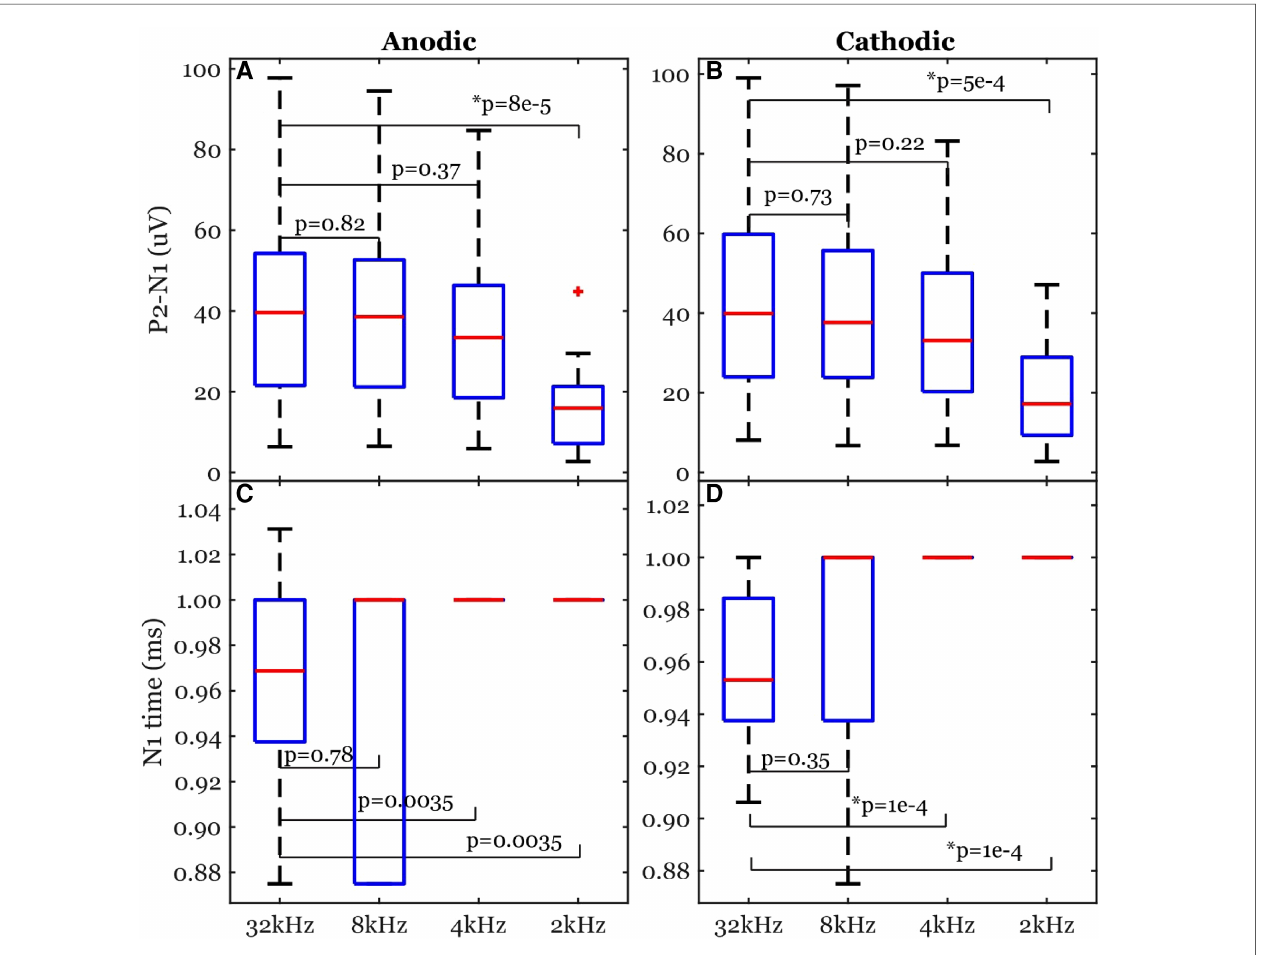
FIGURE 10 Common ECAP characteristics: ( A,B ) peak-valley amplitude (P2-N1) and ( C,D ) N1 time; across the four sampling frequencies: 32, 8, 4, and 2 kHz. The p -values are established from linear models. The data included 20 observations from two participants with stimulation amplitudes suf fi cient to evoke ECAP in each